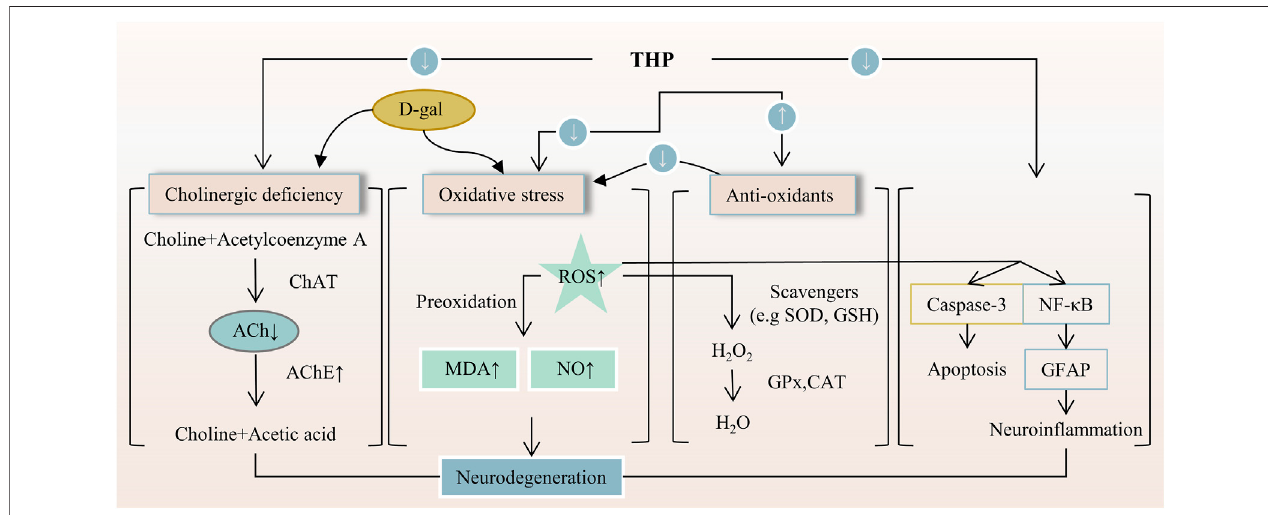
FIGURE 5 | The main targets and pathways of neuroprotective activity of THP. Abbreviations:D-gal, D-galactose; ChAT, Choline acetyltransferase; ACh, Acetylcholine; AChE, Acetylcholinesterase; ROS, Reactive oxygen species; MDA, Malondialdehyde; NO, Nitric oxide; SOD, Superoxide dismutase; GSH, Glutathione; GPx, Glutathione peroxidase; CAT, Catalase; NF- κ B, Nuclear factor-kappa B; GFAP, Glial fi brillary acidic